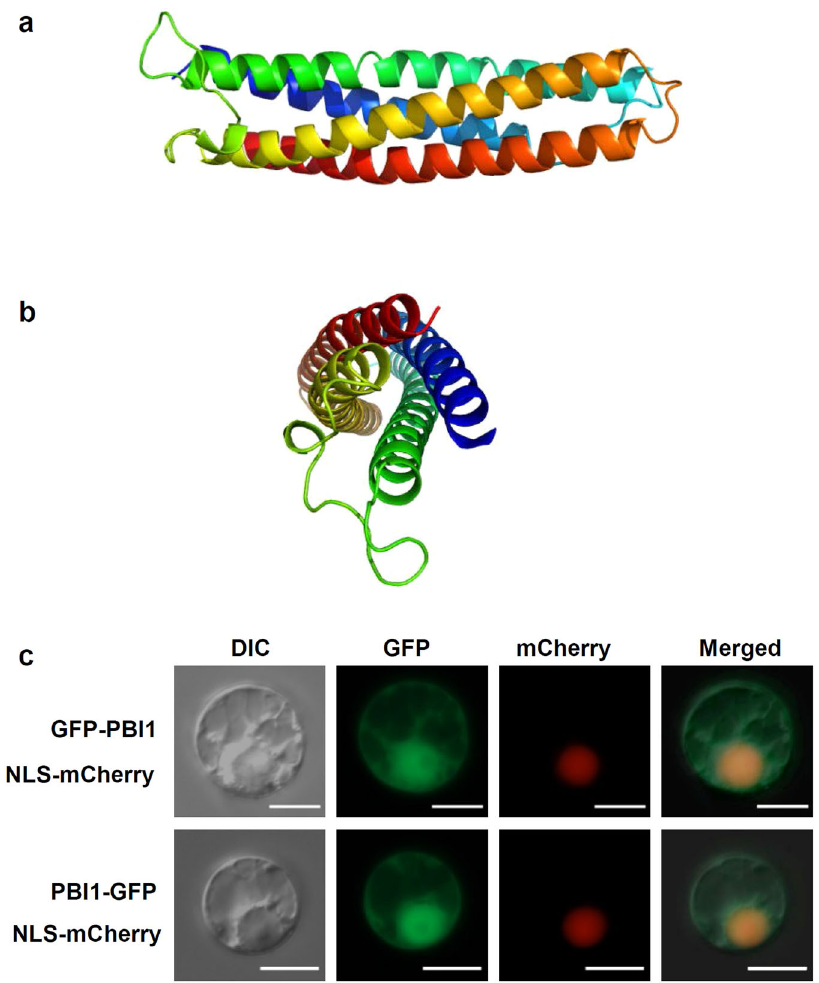
Fig. 3 PBI1, with a four-helix bundle structure, localizes mainly to the nucleus. a Side view of PBI1, which forms a four-helix bundle. Coloring is from blue at the N-terminus to red at the C-terminus. b End view, with N- and C-termini at the front. c Detection of GFP-PBI1 and PBI1-GFP after transient expression in rice protoplasts. mCherry with a nuclear localization signal was used as a nuclear localization marker. Scale bar = 10 µ m. Similar results were obtained in three independent